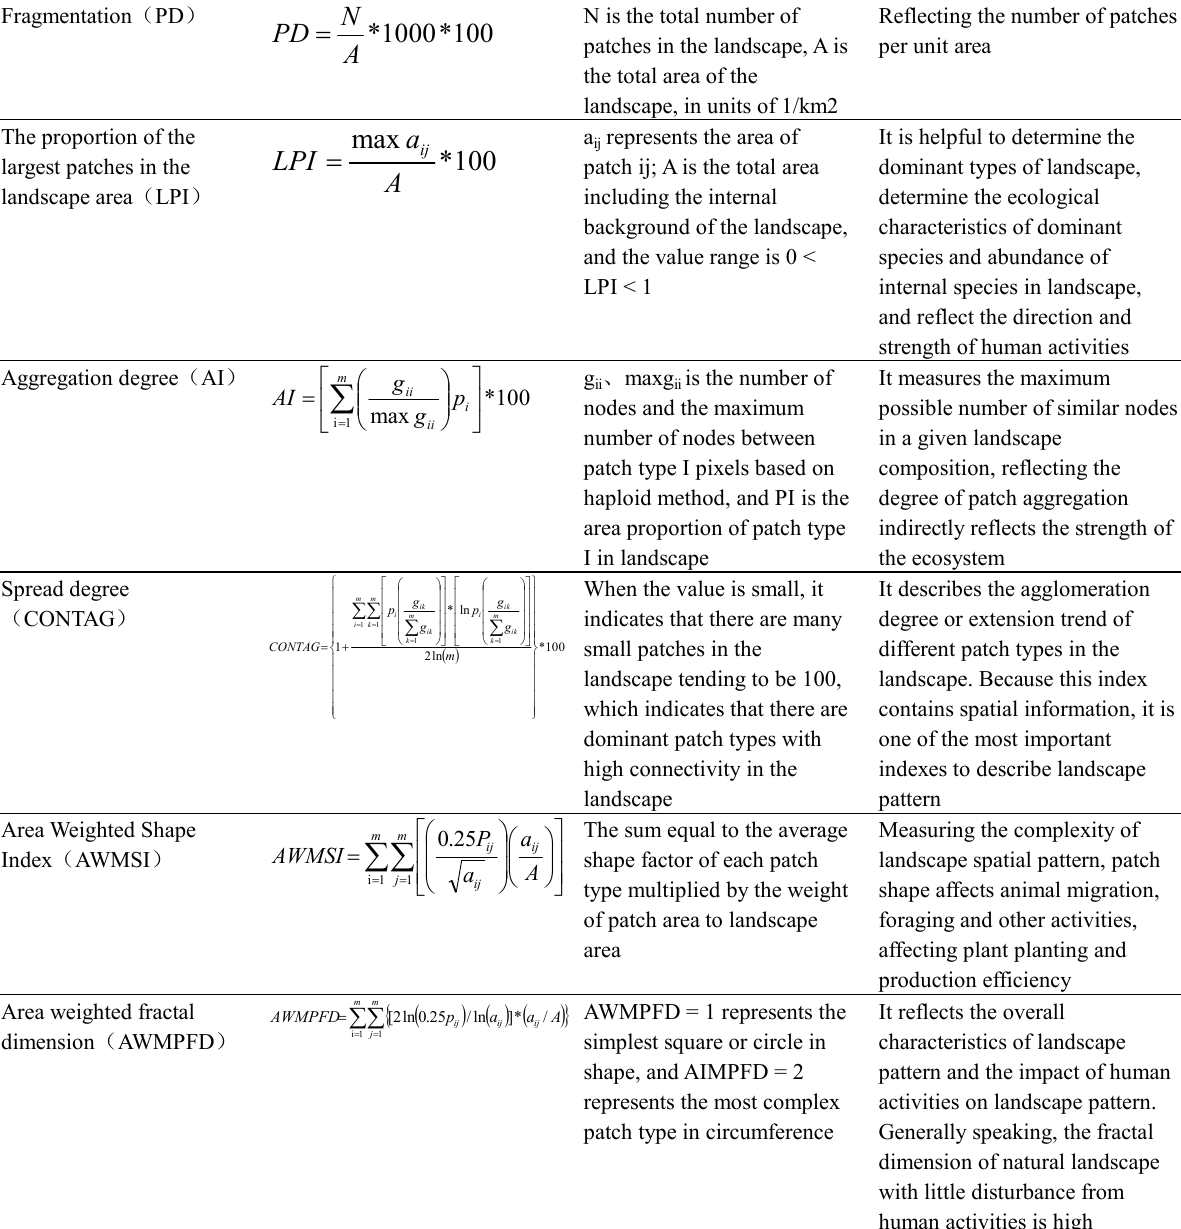
Table 1. Statistical table of